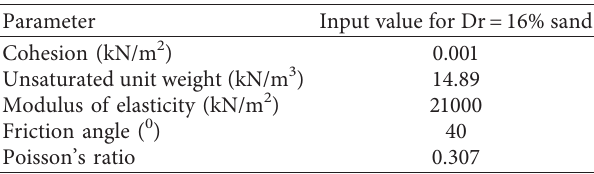
Table 7: Plaxis 3D input parameters of sand.